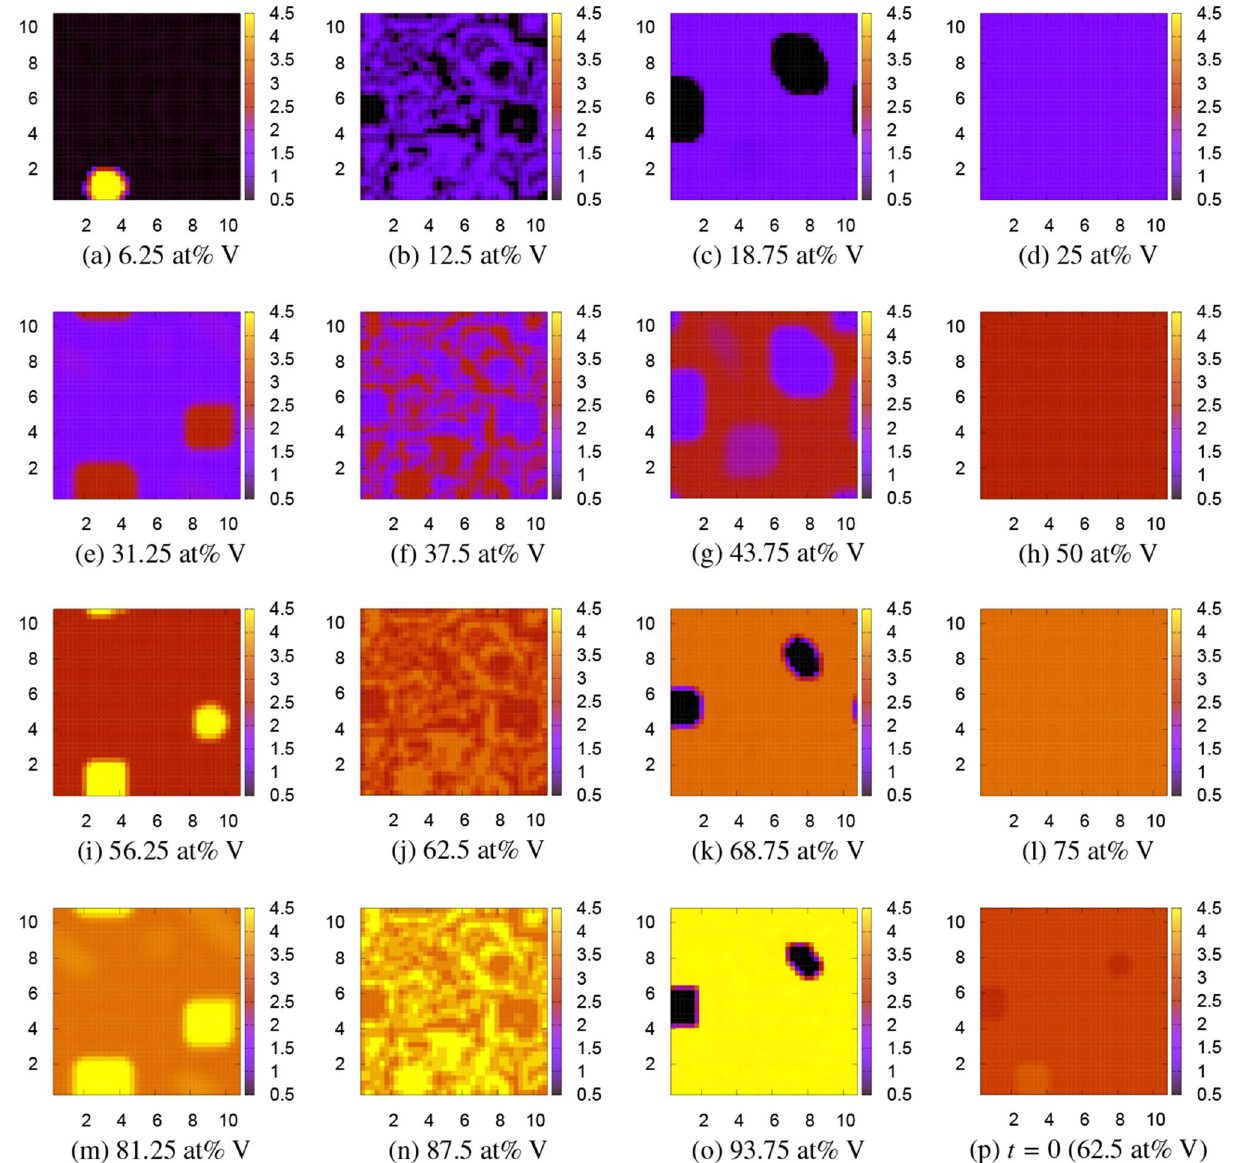
Figure 4. Microstructures of the Ti 4 tetrahedron approximation at 0 K. The color bar indicates the V concentration φ V The scales in x and y axes can roughly be regarded as the order of μm. The patterns do not change at all at 1300 K. (p) is the initial pattern at t